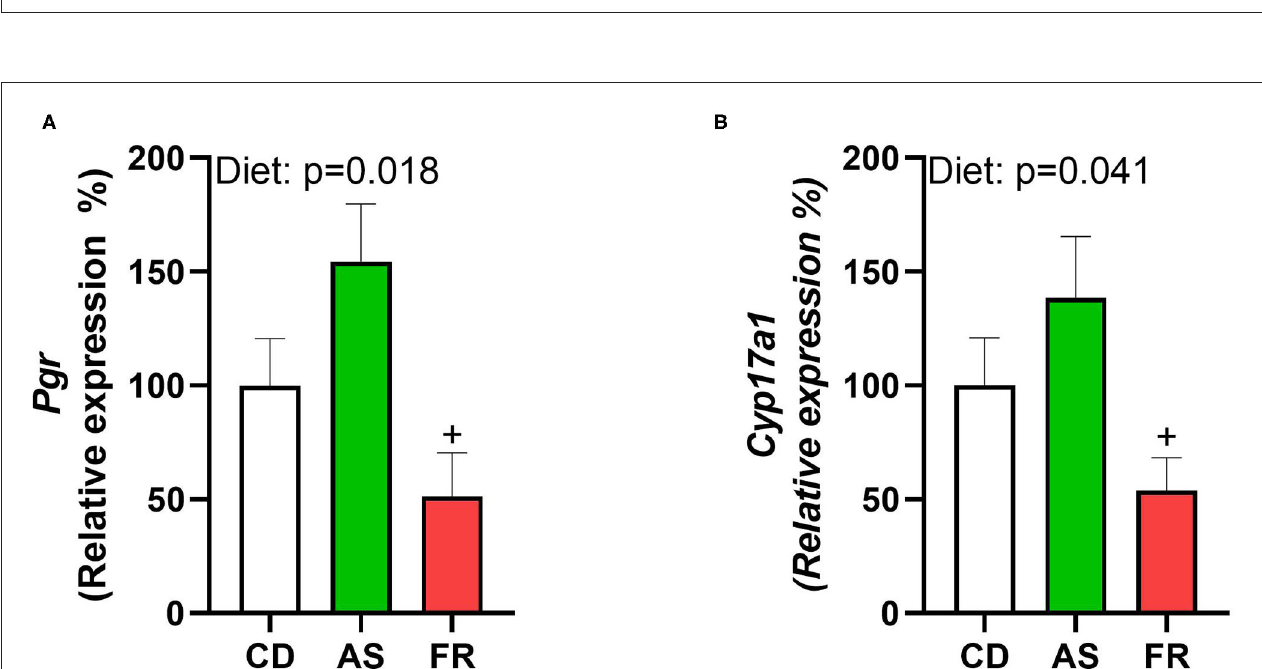
FIGURE 6 | The impact of maternal Ace-K (AS) and fructose (Fr) intake compared to Controls (CD) on ovarian gene expression in female C57BL/6 offspring. (A) Pgr , (B) Cyp17a1 . Data were analyzed using one-way ANOVA. Data are expressed as mean ± SEM. + P < 0.05w.r.t AS; n = 8 per group.